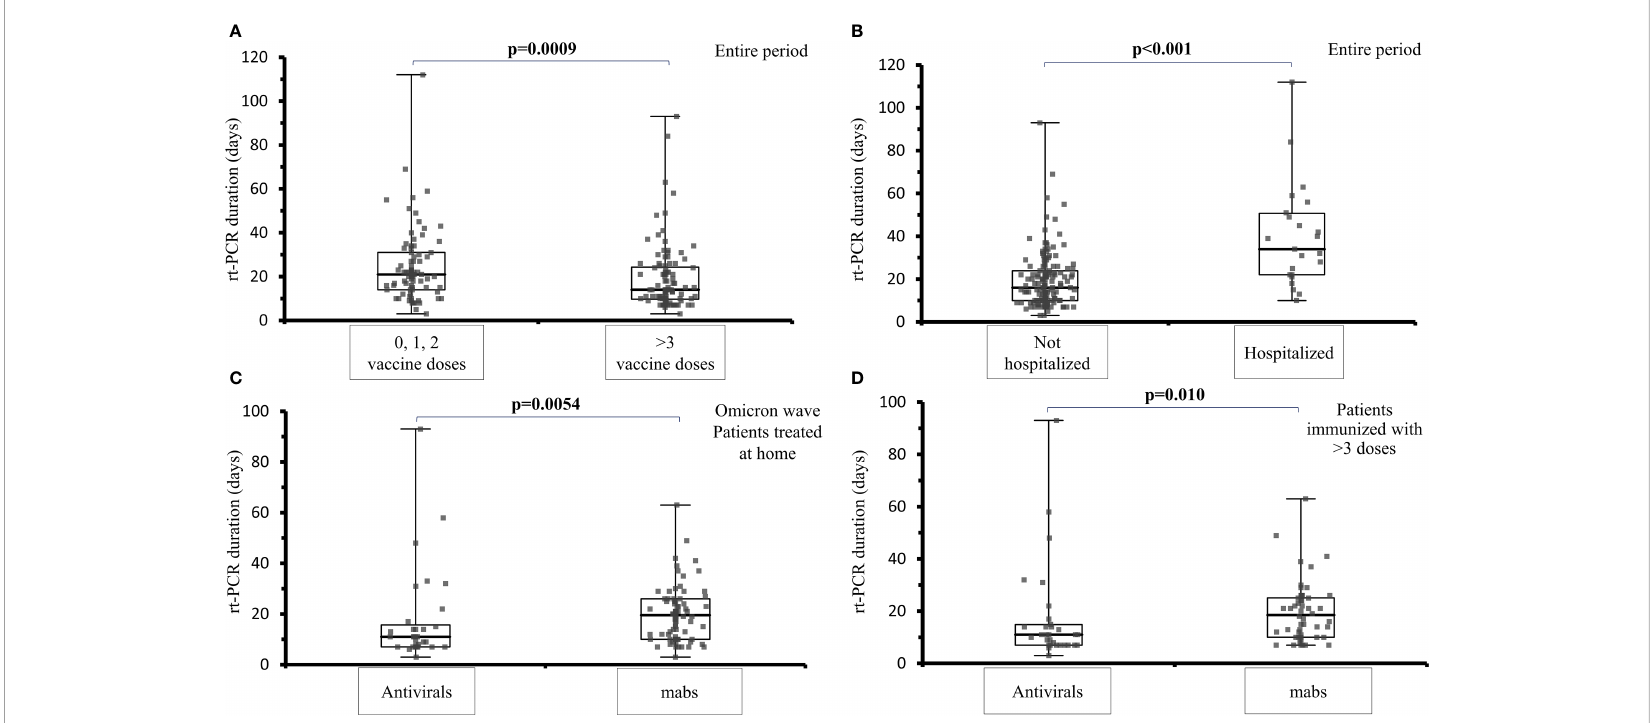
FIGURE 2 Analysis of viral shedding (SARS-CoV-2 rt-PCR in naso-pharyngeal swab) duration in days in different subsets of IEI patients. (A) viral shedding duration at fi rst infection among IEI patients not vaccinated or immunized with 1 or 2 mRNA vaccine doses and IEI patients who had received 3 or 4 vaccine doses, during the entire examined period (median: 14 days, IQR 9.7-24.3 days vs 21 days, IQR 14-31 days; p=0.0009). (B) comparison of the viral shedding duration in IEI hospitalized (median: 34 days; IQR 22-51 days) and non-hospitalized patients (median: 16 days; IQR 10-23.75 days, p < 0.001), during the entire examined period. (C) comparison of the viral shedding duration among IEI patients treated at home with mabs or antivirals at the fi rst infection, during the Omicron wave (median 11 days, range 7-15.7 vs 19.5 range 7-26 days, p=0.0054) (D) comparison of viral shedding in patients vaccinated with at least 3 doses receiving treatment with antivirals or mabs (11.0 days, IQR 7.0-14.8 vs 18.5 days, IQR 10.0-25.1;